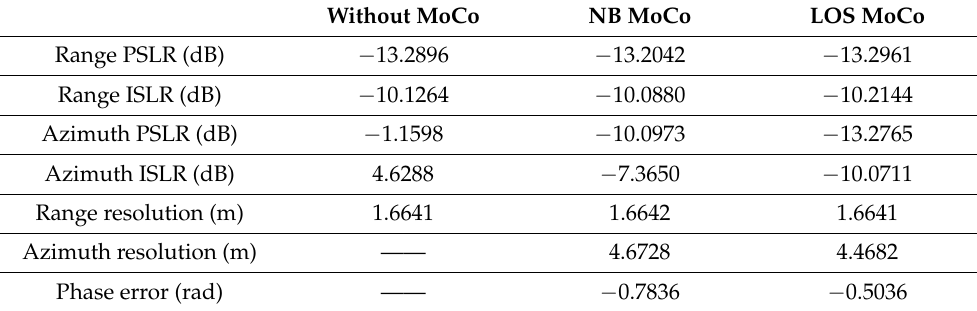
Table 2. Quantitative performance comparison of points in the rectangle.